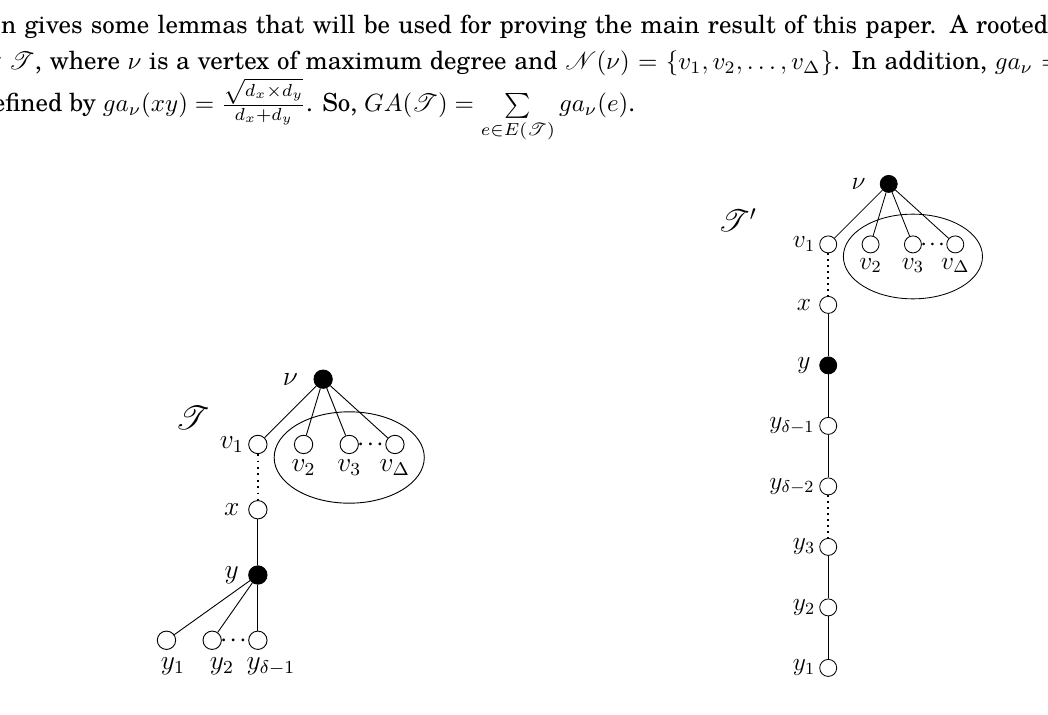
Figure 1: The trees T and T (cid:48) used in the proof of Lemma